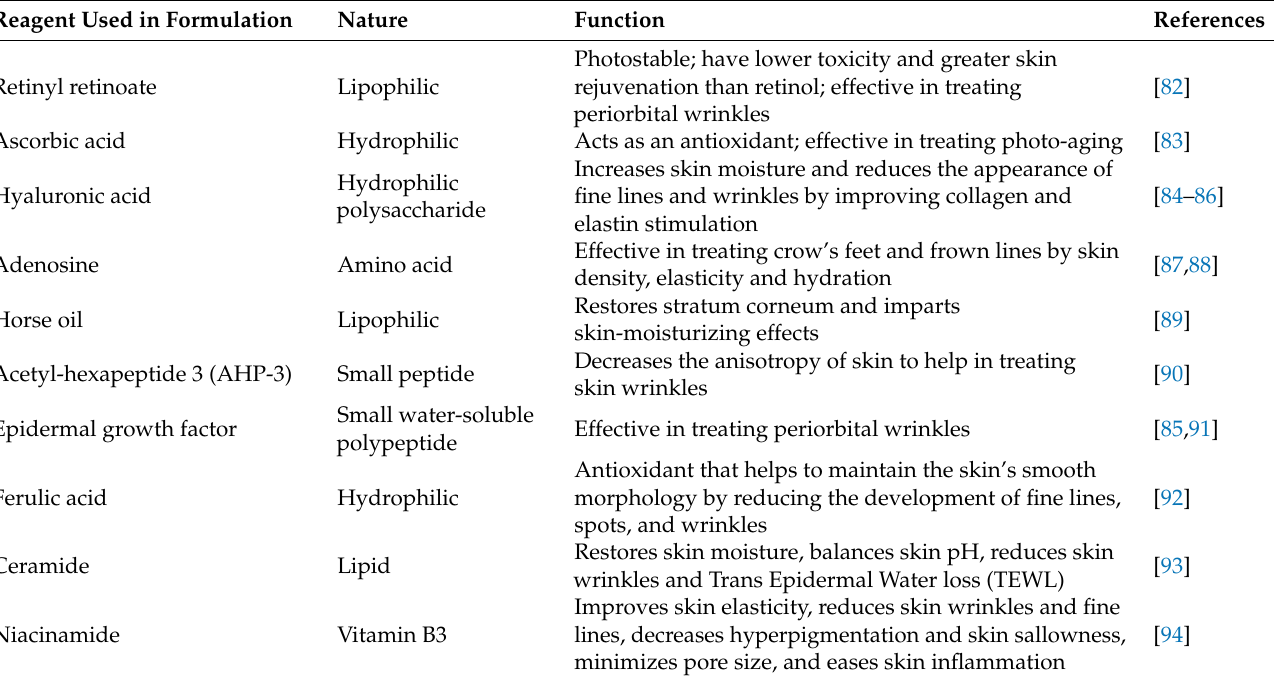
Table 2. Current anti-wrinkle agents in